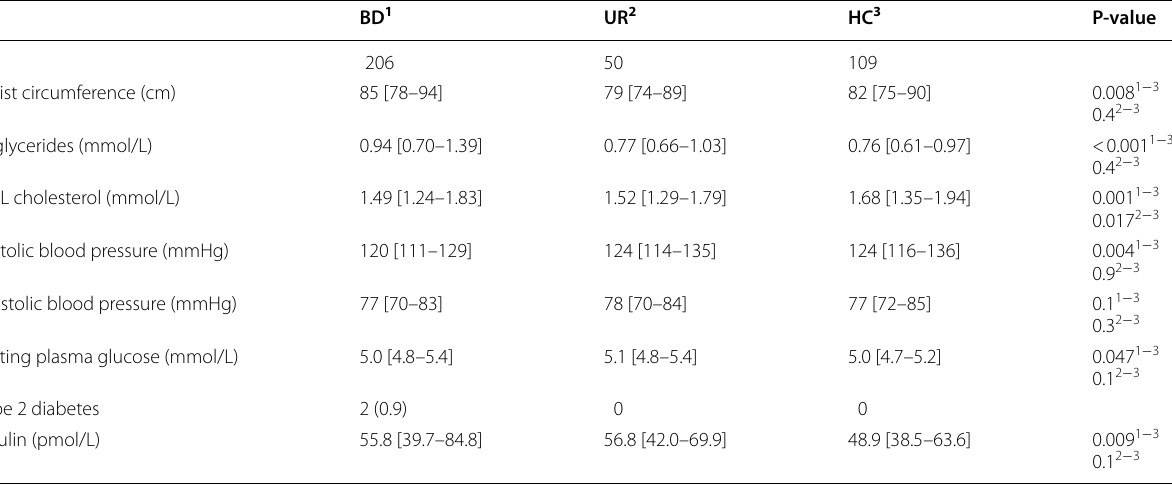
HDL high density lipoprotein, MmHg millimeters of mercury. Continuous variables are presented as median [interquartile range] Table 4 Metabolic syndrome and insulin resistance in patients with bipolar disorder